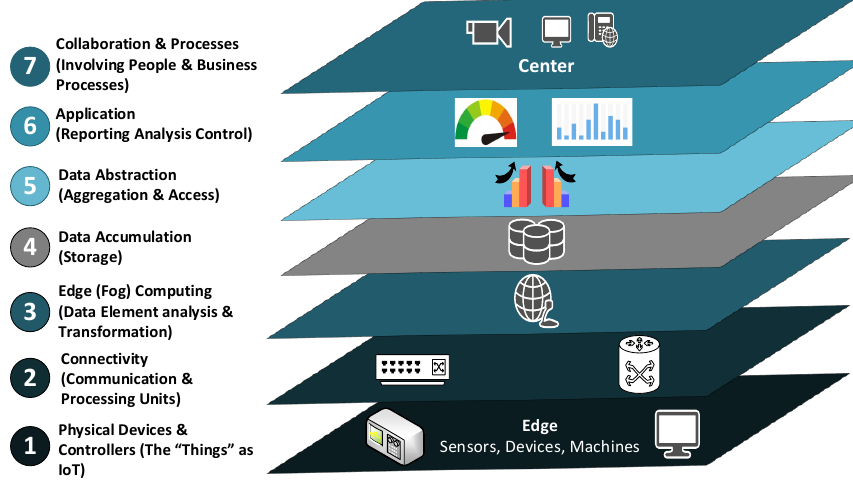
Figure 6. Cisco IoT reference model